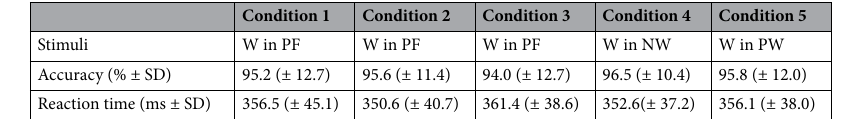
Table 1. Accuracy and reaction time of responses to cross color change. Values are mean